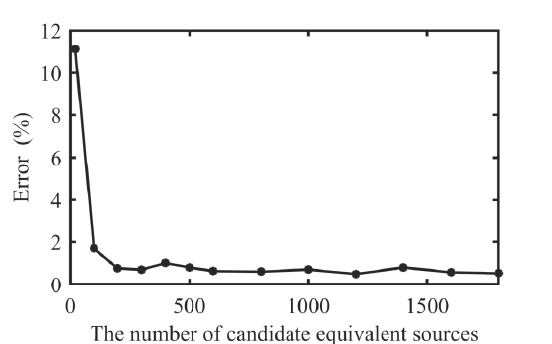
Figure 3. The relative error versus the number of equivalent source